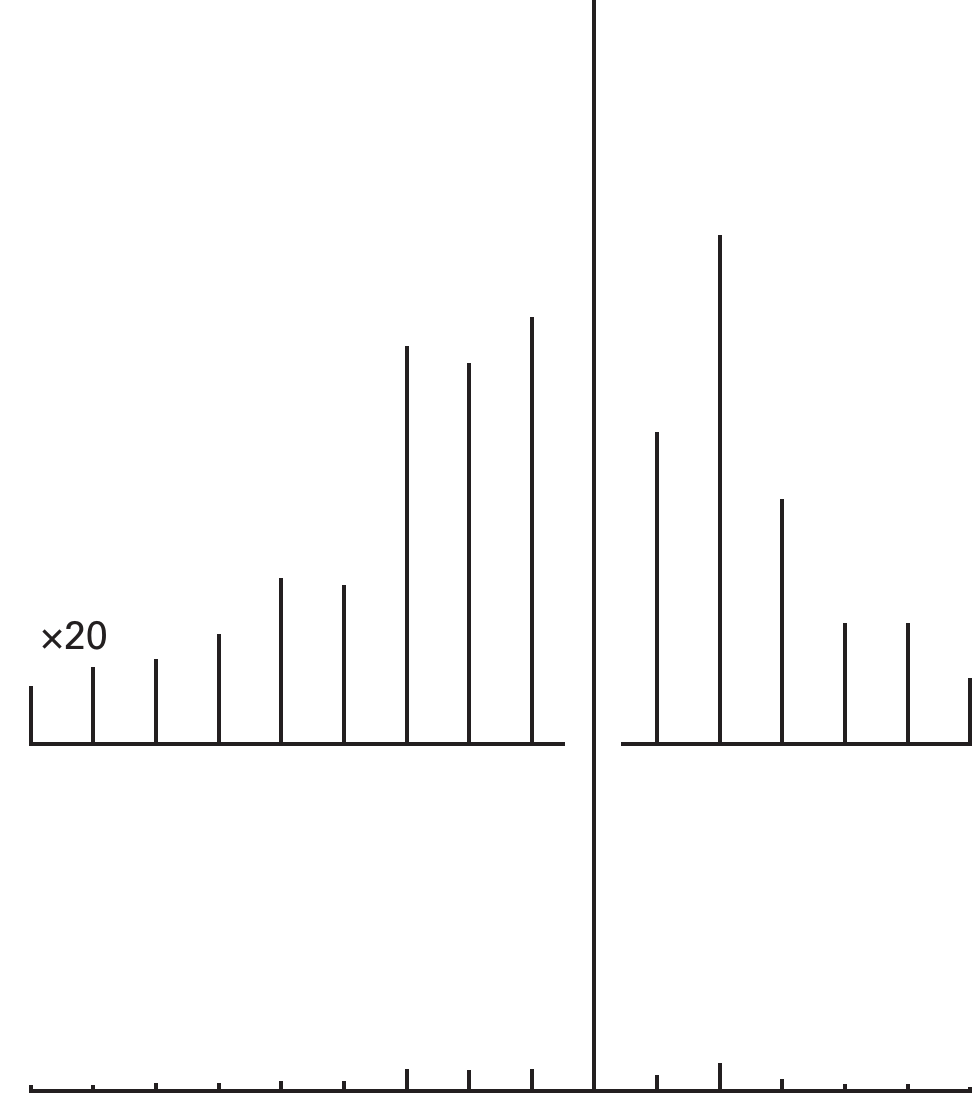
Figure 8. Calculated spectral output using parameters obtained from Figure 5. Wavelength is along the abscissa and power is along the ordinate. Adapted with permission from Figure 5 of [30] ©The Optical